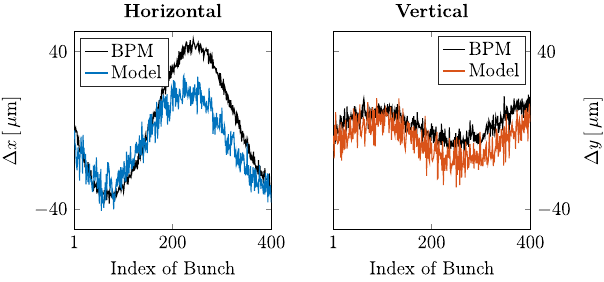
FIG. 7. Difference between the reference offset and the offset while a 3 kHz modulation is applied on the forward power. The BPM readout differences (black) and the corresponding model evaluations (colored) are plotted for the horizontal (left) and vertical (right) plane.